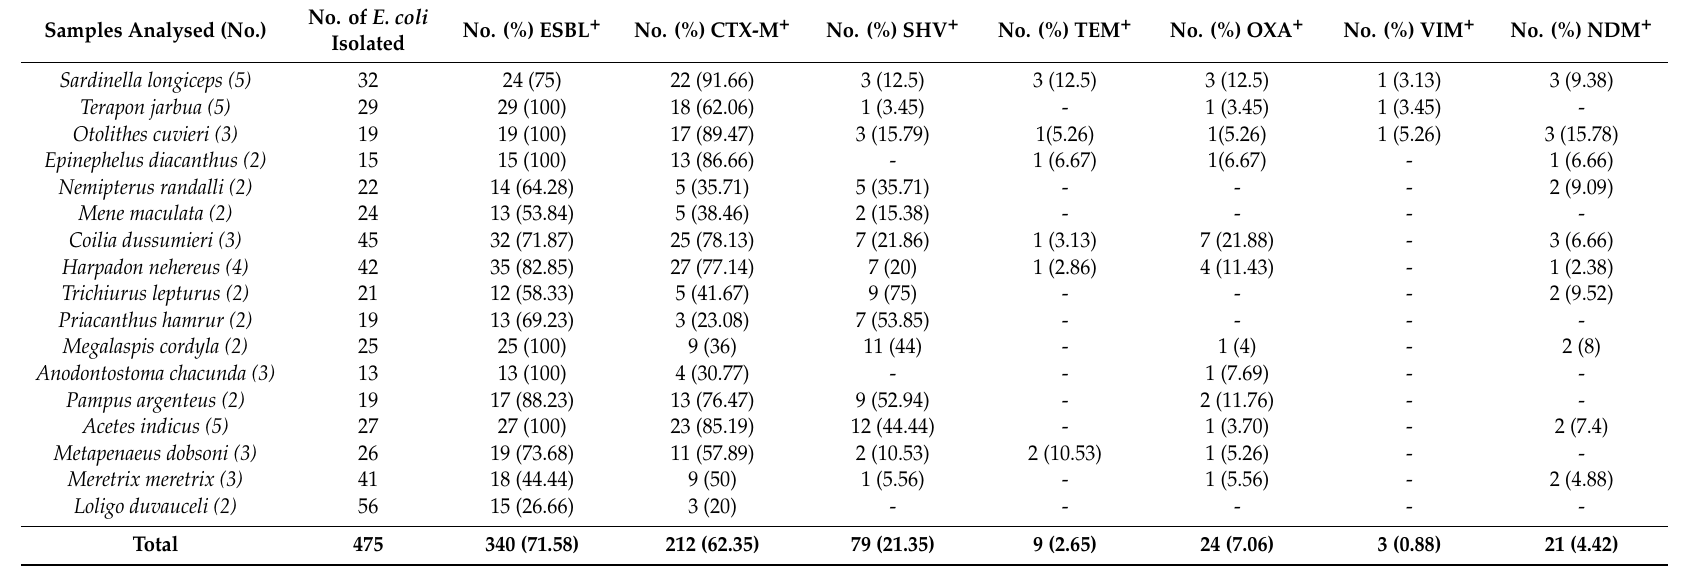
Table 3. Distribution of β -lactamase genes in Escherichia coli isolated in this